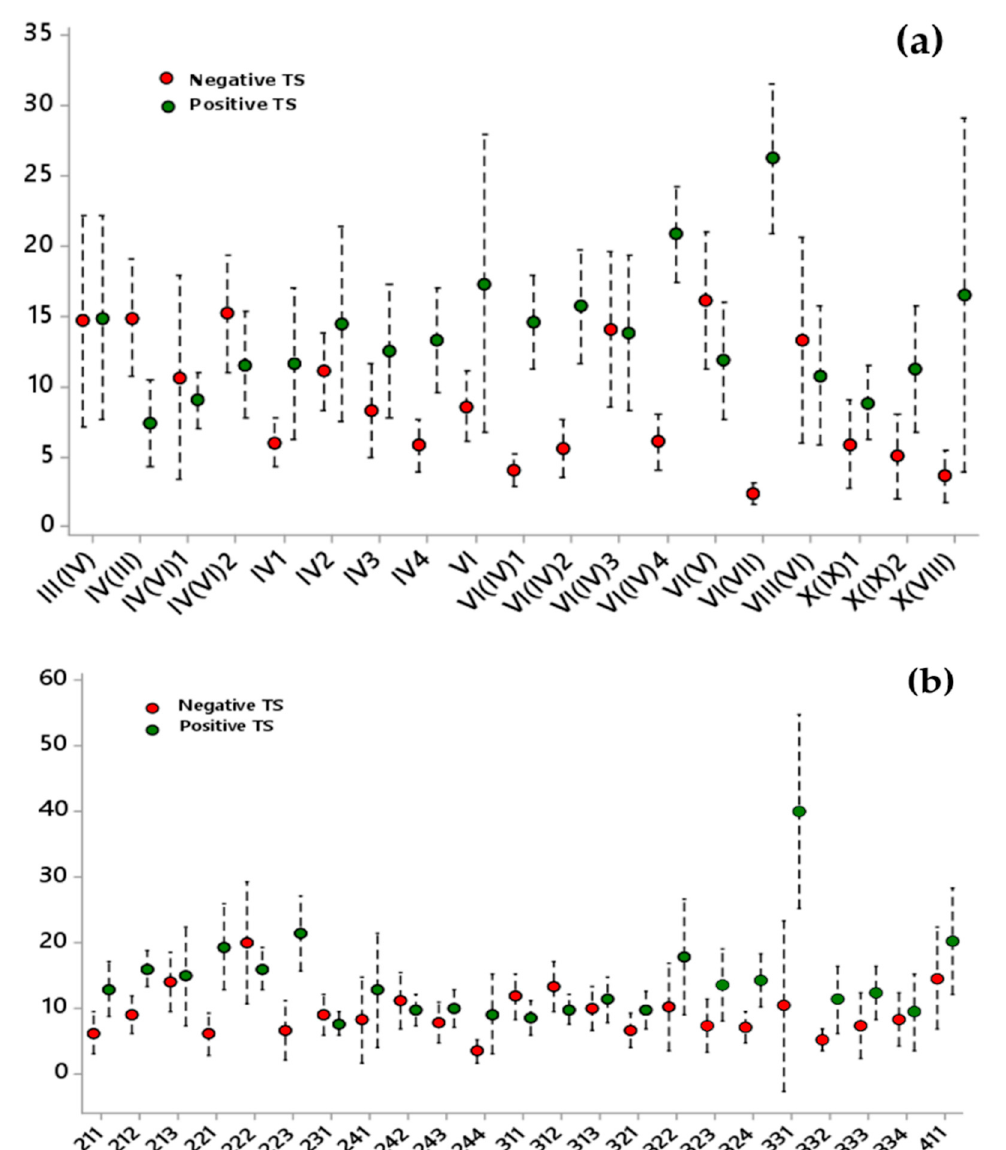
Figure 7. Interval plots (95% CI) from the variance analyses. The x -axis labels are the Allué phytoclimatic regions ( a ) and the CLC codes; ( b ) the y -axis shows the percentage of significant ( p < 0.1) positive (in green color) and negative (in red color) trend pixels.